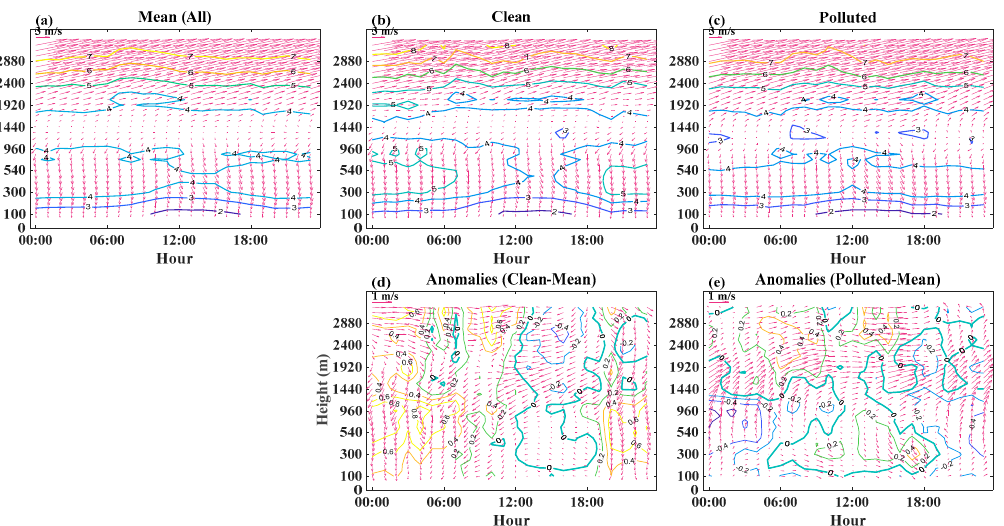
Figure 4. Diurnal variations of horizontal wind vectors (vectors) and wind speed (colored lines) under ( a ) climate mean, ( b ) clean, and ( c ) polluted conditions, and the anomalies (relative to climate mean) under ( d ) clean and ( e ) polluted conditions in CS for winters from 2016–2020.